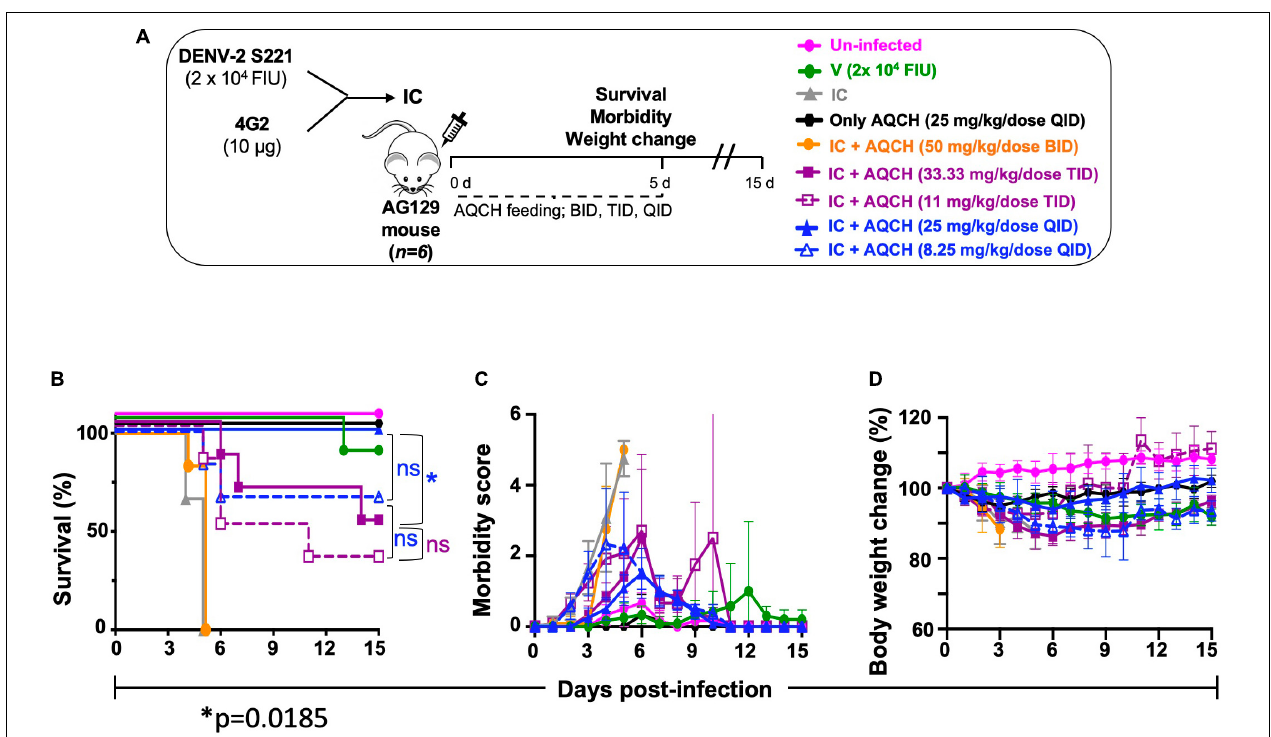
FIGURE 5 | Effect of AQCH dose and dosing regimen against secondary DENV infection: (A) schematic representation elaborating that AG129 mice ( n = 6) were injected with sub-lethal dose of DENV-2 S221 alone (marked as V; green curve) or as DENV-2 S221-4G2 IC (IC). IC injected AG129 mice were orally fed with either AQCH at indicated higher (solid curve) and lower (dashed curve) doses or only methylcellulose (marked as IC; gray curve) for 5 days in BID (orange), TID (purple), and QID (blue) dosing regimens. Uninfected (magenta curves) and Only AQCH (black curves) groups of AG129 mice were used as experimental controls. (B–D) represents their survival curves, morbidity score, and % body weight changes, respectively, which were observed during entire study duration of 15 days. Statistical differences (ns; not significant, and *; less significant) of survival between different dosing schedules are represented on the right side of graph.